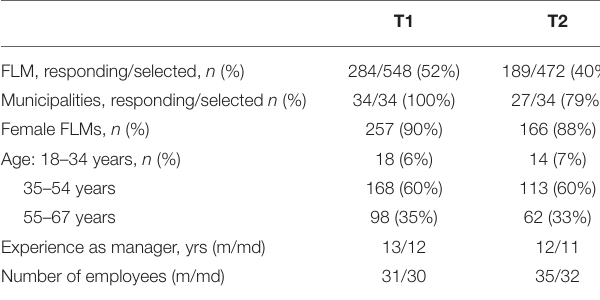
TABLE 1 | Demographic information of responding first line managers